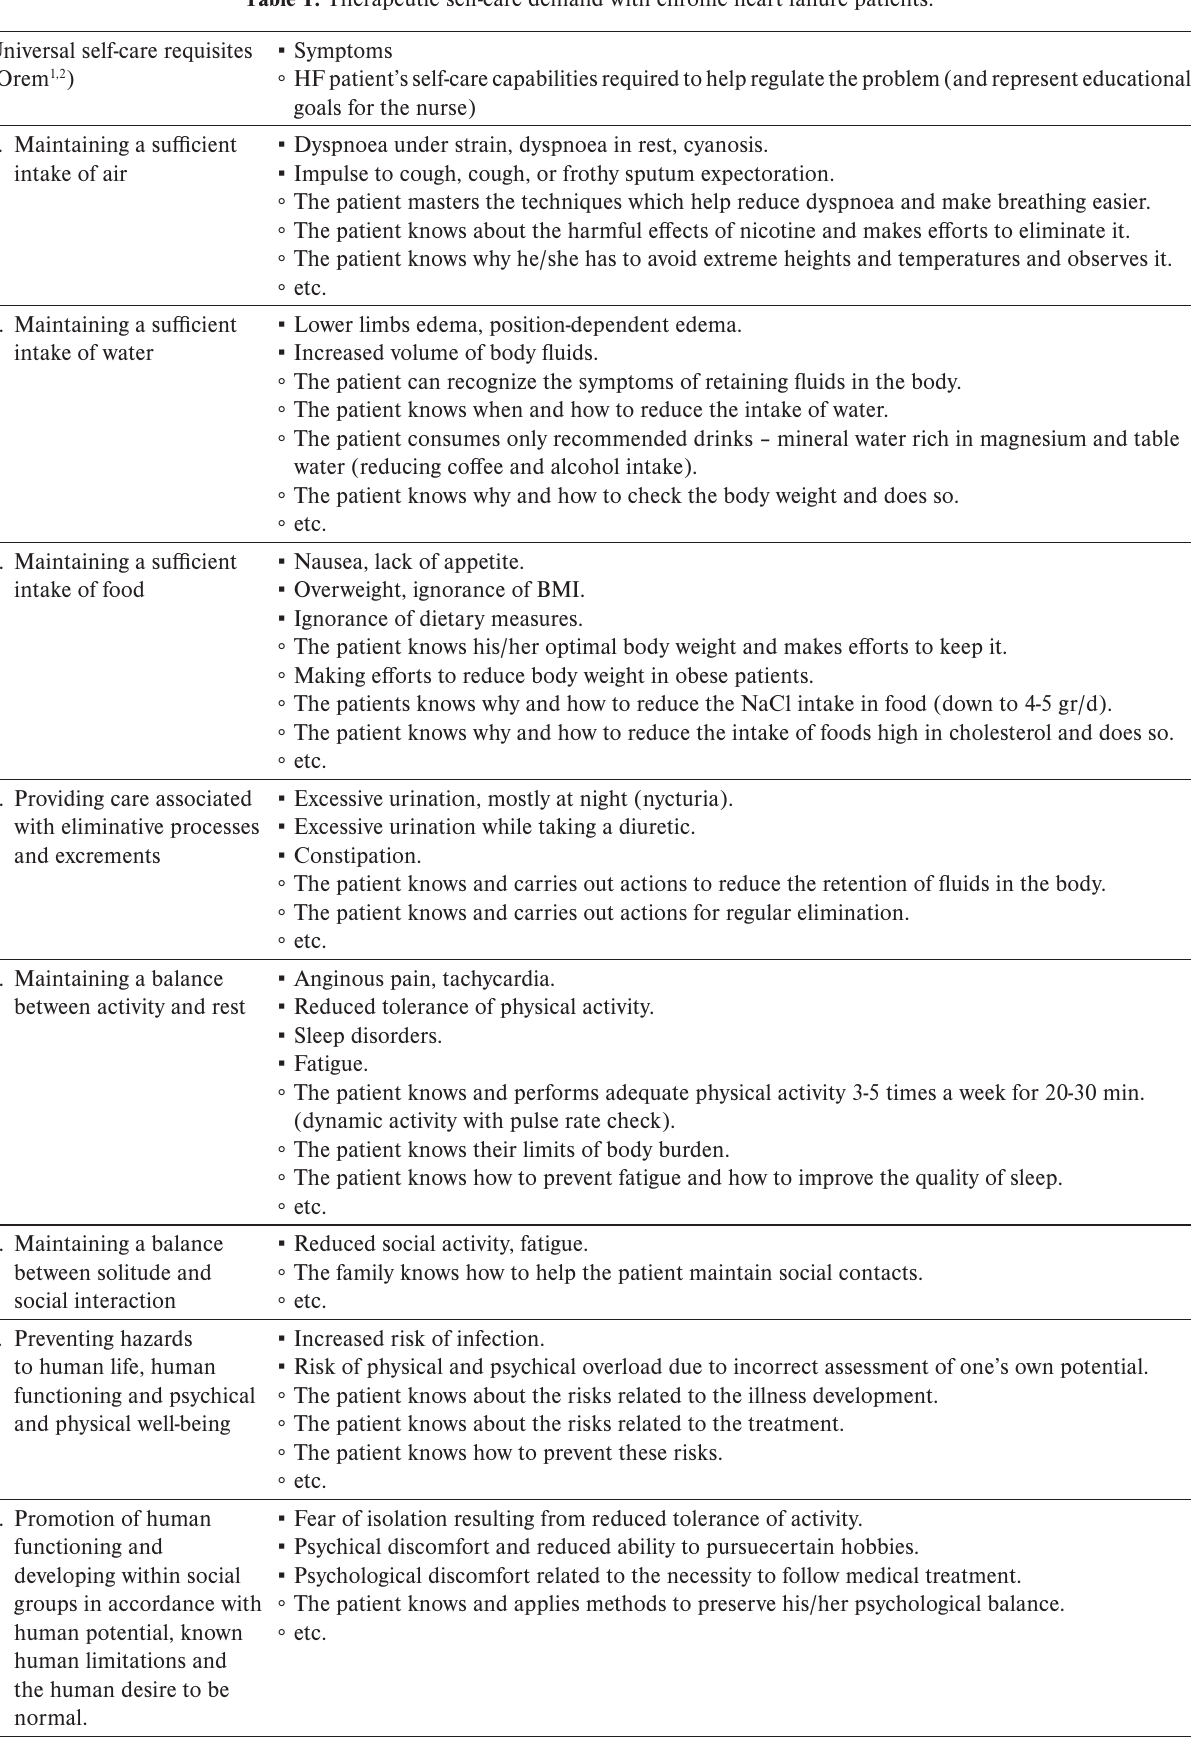
Table 1. Therapeutic self-care demand with chronic heart failure